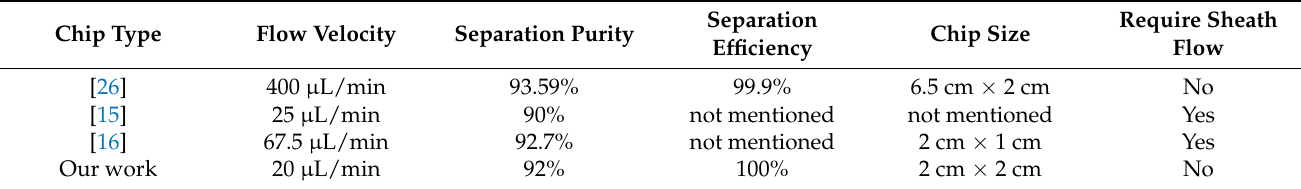
Table 2. Comparison list of different